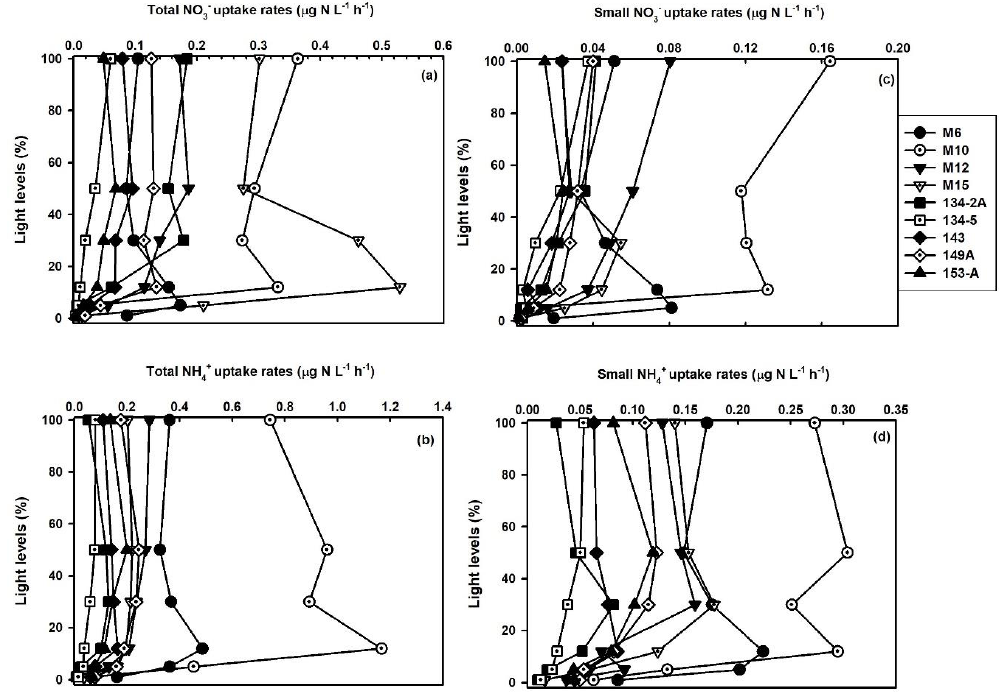
Figure 4. Depth profiles of total and small NO 3− and NH 4+ uptake rates in the East/Japan Sea during 2015. ( a , b ) denote the total phytoplankton NO 3− and NH 4+ uptake rates, respectively, and the ( c ) and ( d ) denote the small phytoplankton NO 3− and NH 4+ uptake rates, respectively. Compared to the other stations, stations M1, M4, and M11 showed relatively higher surface NO 3− uptake rates, whereas surface NH 4+ uptakes were higher at M4 and M11. The total NO 3− uptake rates